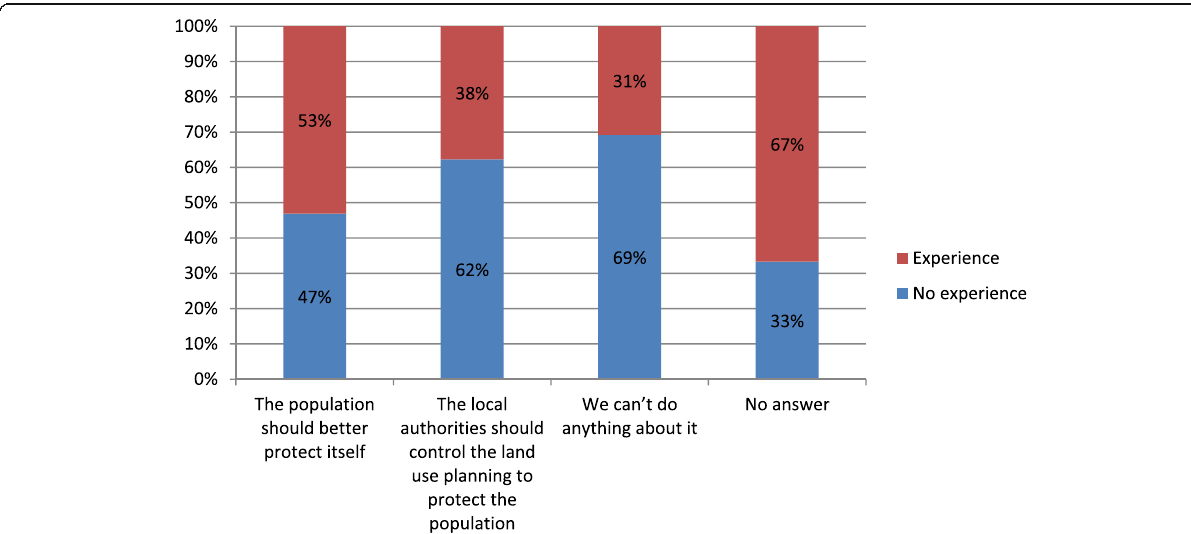
Fig. 9 Answer to the question: “ Here are several suggestions. Which is the one that is closest to your opinion about lahars? ” (experience in lahars N = 82 / no experience in lahars N = 118 – all areas) - [Chi 2 = (5,44); p = .14 ; df =